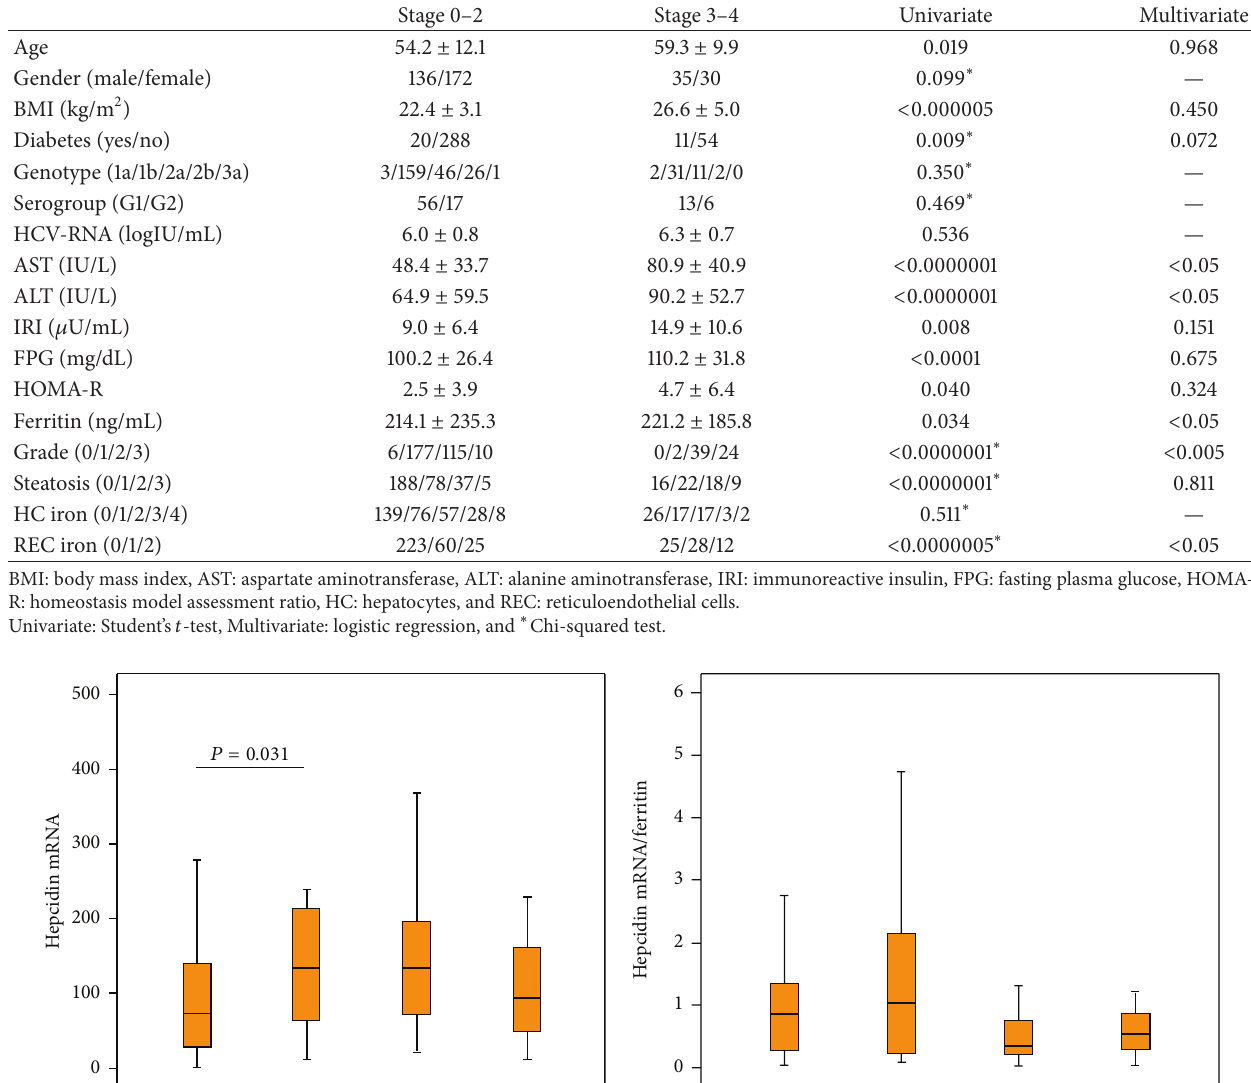
Table 2: Logistic regression analysis of factors associated with advanced stage.